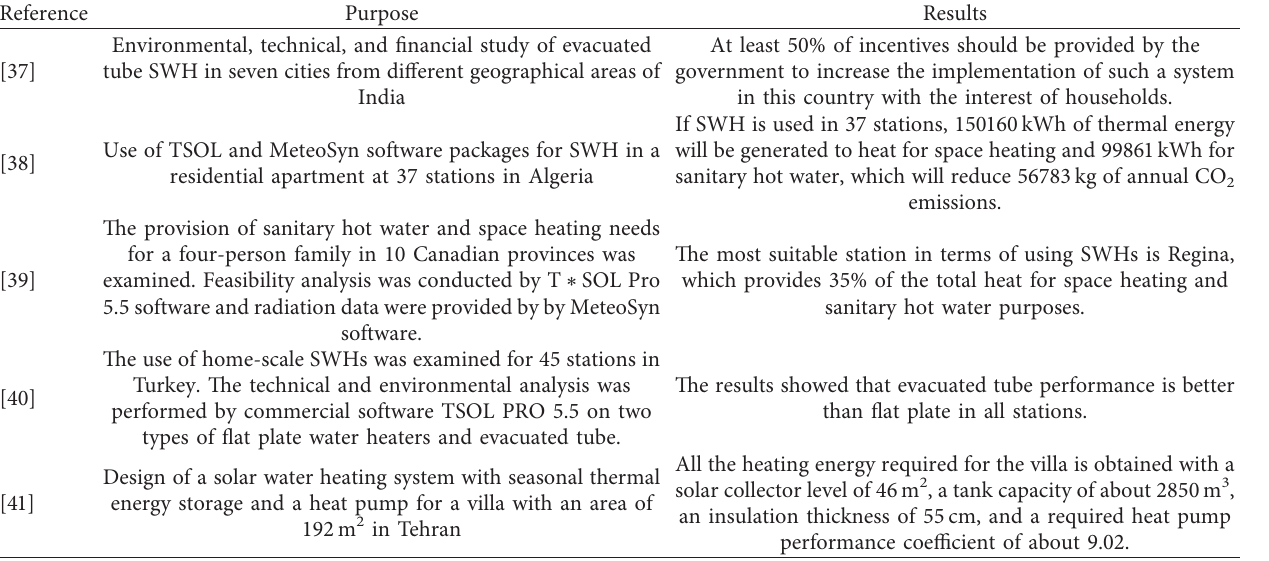
Table 2: Recent studies in the field of SWHs in Iran and the